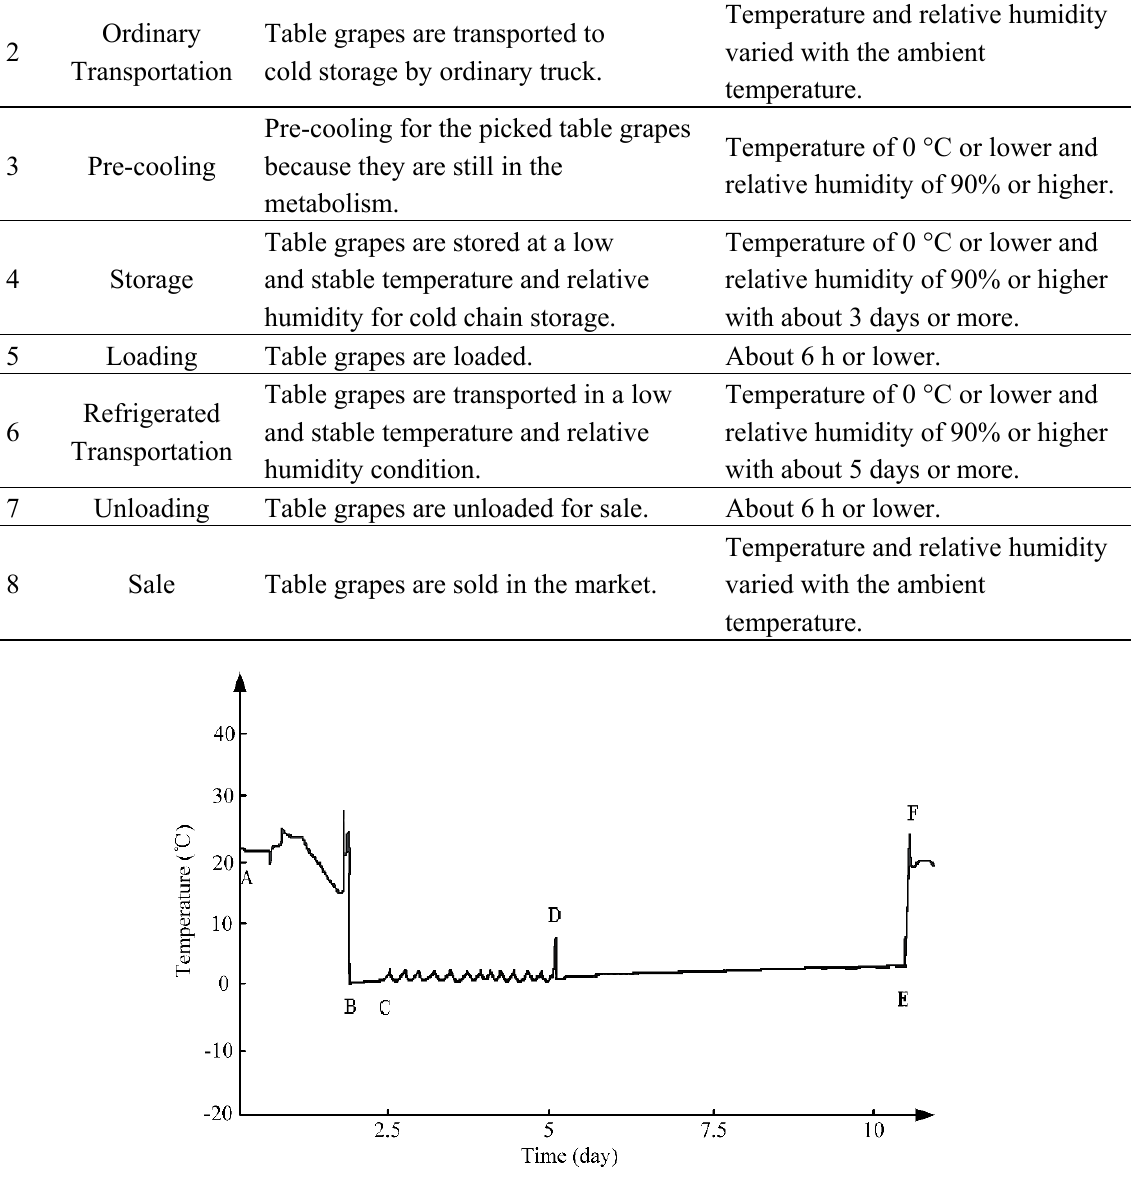
Figure 5. The curve of the temperature in the table grapes’ cold chain